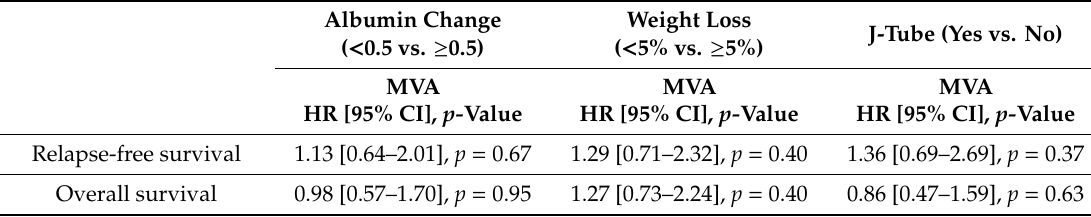
Table 5. Associations between nutritional markers and relapse-free and overall